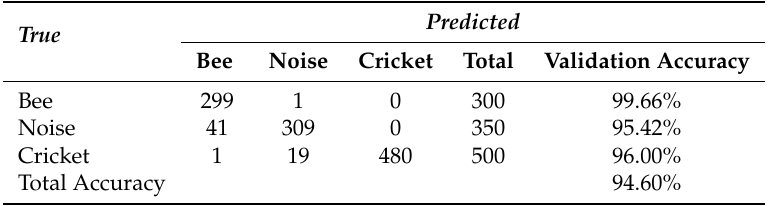
Table 12. Confusion matrix for M1 (logistic regression) on BUZZ1 validation dataset.